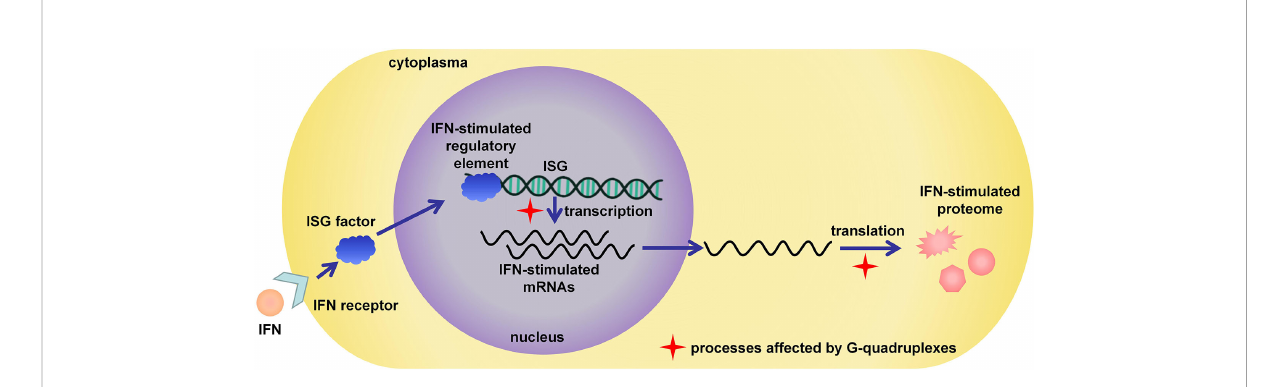
FIGURE 4 IFN-stimulated antiviral response and related bioprocesses possibly affected by